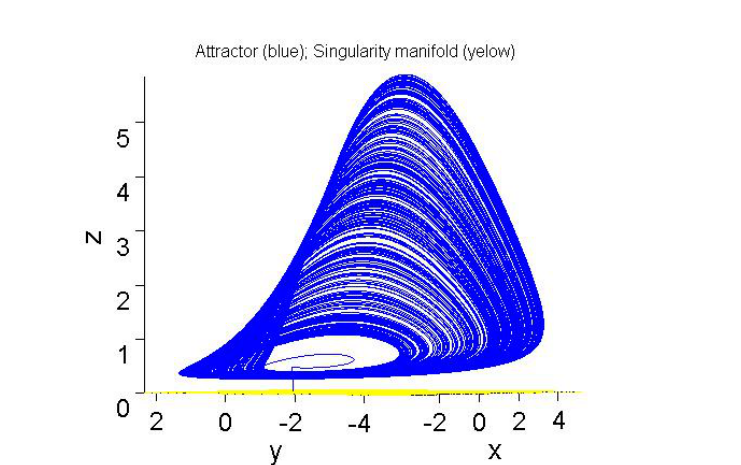
z is selected as O (yellow) when